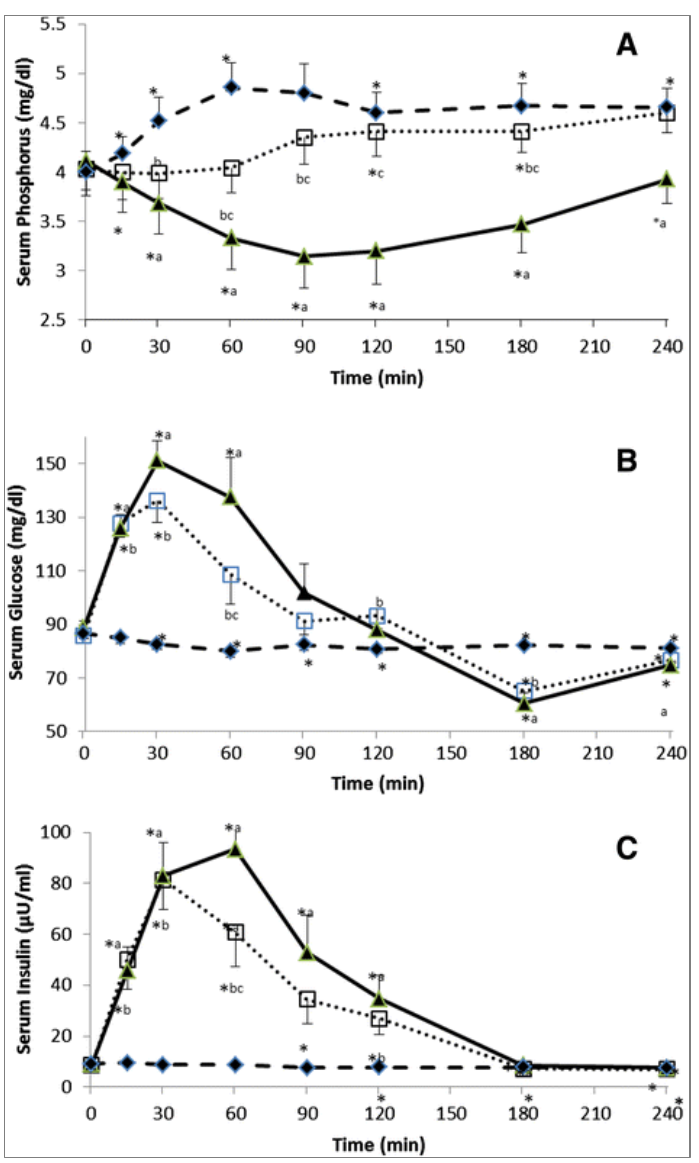
Figure 13. Serum phosphate ( A ), glucose ( B ) and insulin ( C ) in man in response to an oral glucose (75 g) tolerance test ( ), and oral phosphate (500 mg) dose ( ), or the combination of an oral glucose tolerance test plus oral phosphate ( ). * p -value < 0.05: paired t-test in the same treatment in comparison with baseline (time 0) value. a p -value < 0.05: paired t-test, phosphorus vs. glucose treatments at each time point. b p -value < 0.05: paired t-test, phosphorus vs. glucose + phos- phorus treatments at each time point. c p -value < 0.05: paired t-test, glucose vs. glucose + phosphorus treatments at each time point [31].